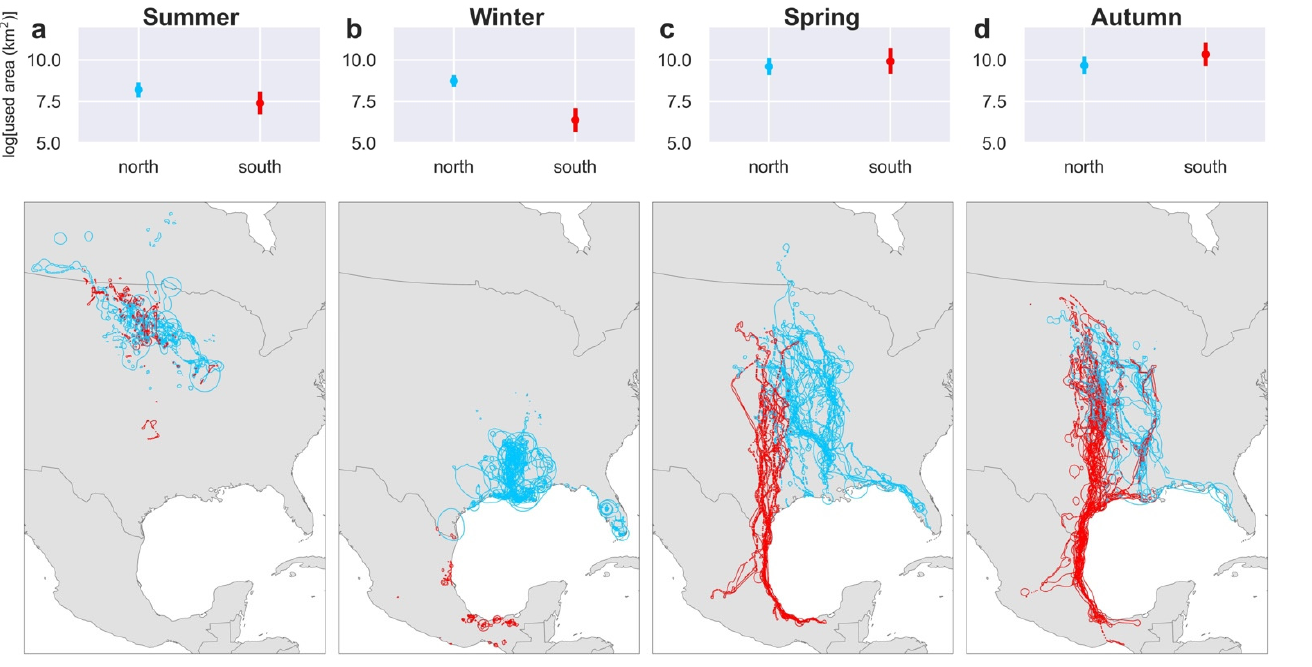
Figure 5. Seasonal home ranges and used areas on the migratory flyway of American White Pelicans estimated by dynamic Brownian bridge movement models. Panels show ( a ) summer, ( b ) winter, ( c ) spring migration, and ( d ) autumn migration. Blue and red polygons represent the home ranges and used areas of pelicans wintering in the Northern and Southern Gulf of Mexico, respectively. The background maps in lower subpanels were produced by ArcGIS Pro [53]. Upper subpanels show the estimates and 95% confidence intervals of log-transformed home ranges and used areas at each wintering group.